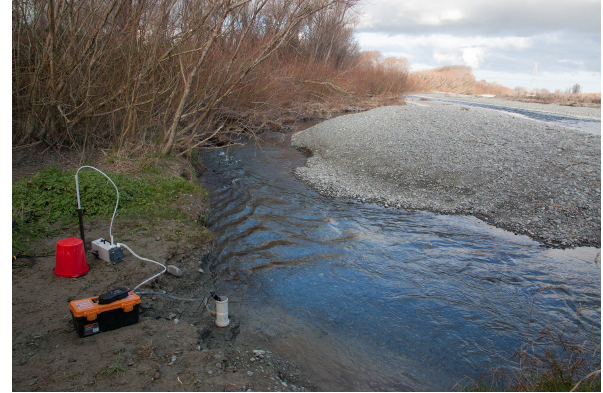
Figure 5. Mini-piezometer installed on the bank of a braided river (Coluccio,